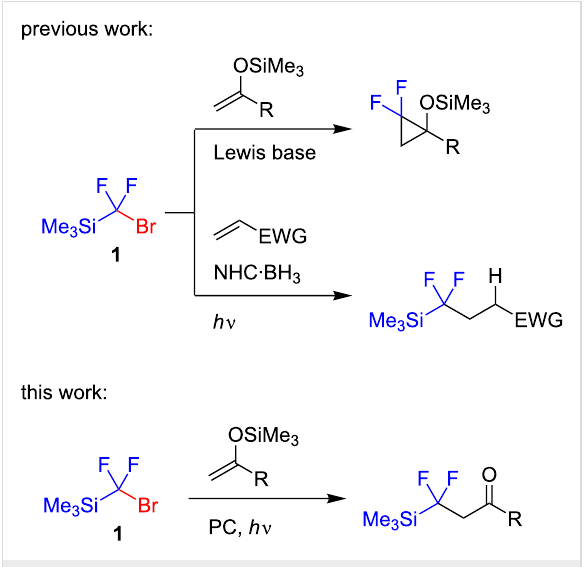
Scheme 1: Reactions of (bromodifluoromethyl)trimethylsilane ( 1 ).